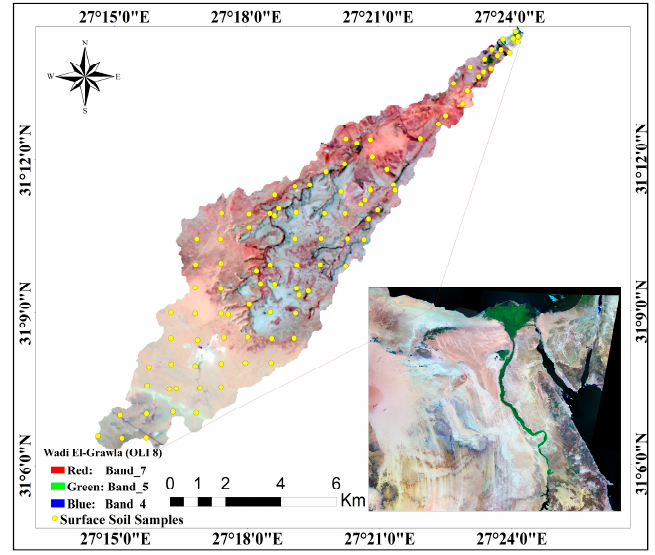
Figure 1. Location of the study area of Wadi El-Garawla and the soil samples as mapped in Landsat 8 satellite imagery (RGB 7, 5, 4).